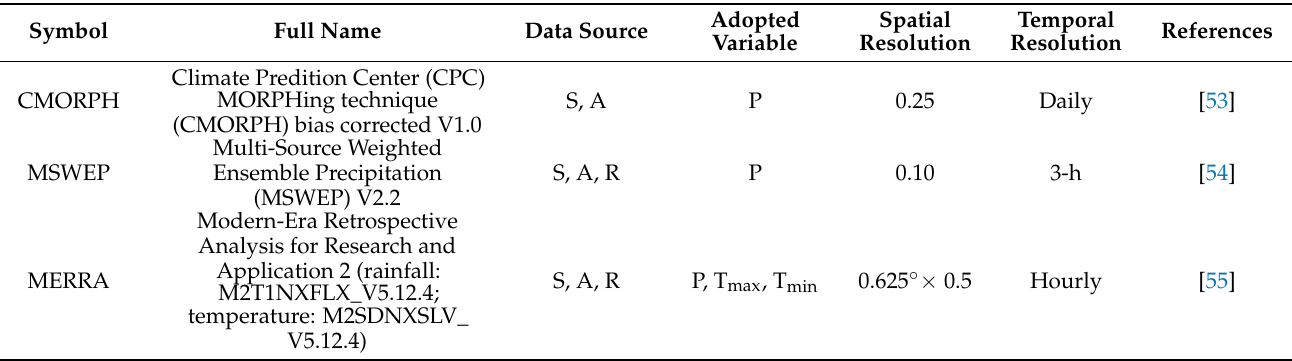
Figure 1. Locations of the selected 356 climate stations, 26 streamflow gauges, and 0.1° × 0.1° grids for hydrological modeling used in this study alongside the maps of three datasets (topography, soil types and land covers). Table 1. List of meteorological grid datasets used in this